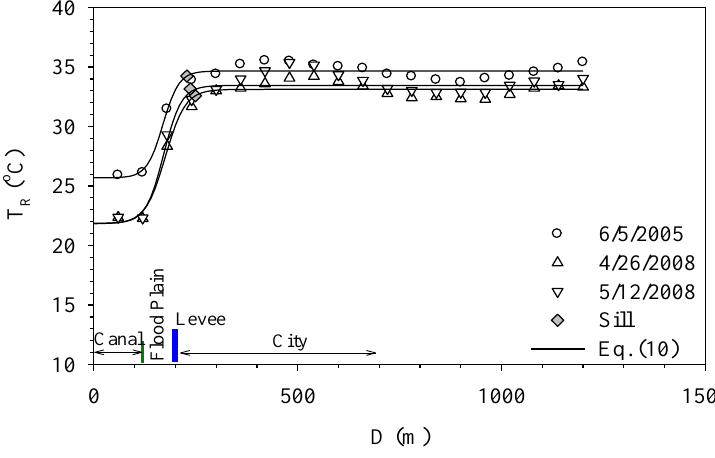
Figure 11. The relationship between the affected range and area of plains and